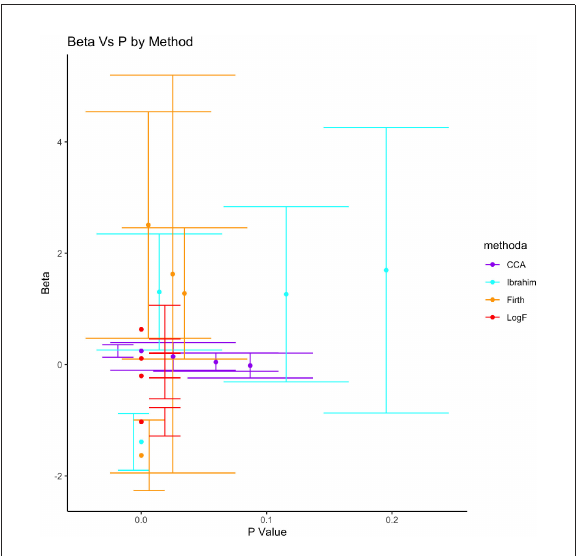
FIGURE2 Validation of LogF against CCA, Ibrahim, and Firth methods.